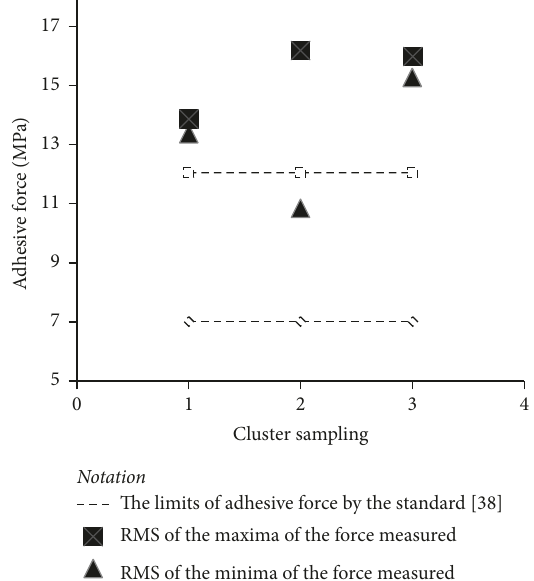
Figure 9: Adhesion control of an unmodified PCS (cluster 1) and the PCSs modified with CSNP (2) or PSNP (3).